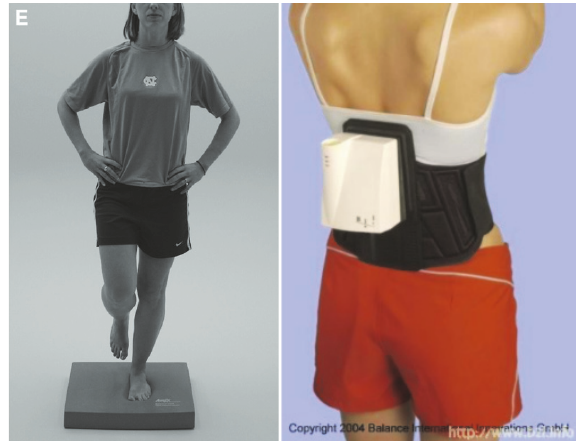
Figure 2: Dominant single-leg stance with foam of the Balance Scoring System (BESS) [29] was recorded with SwayStar (Balance International Innovations GmbH,